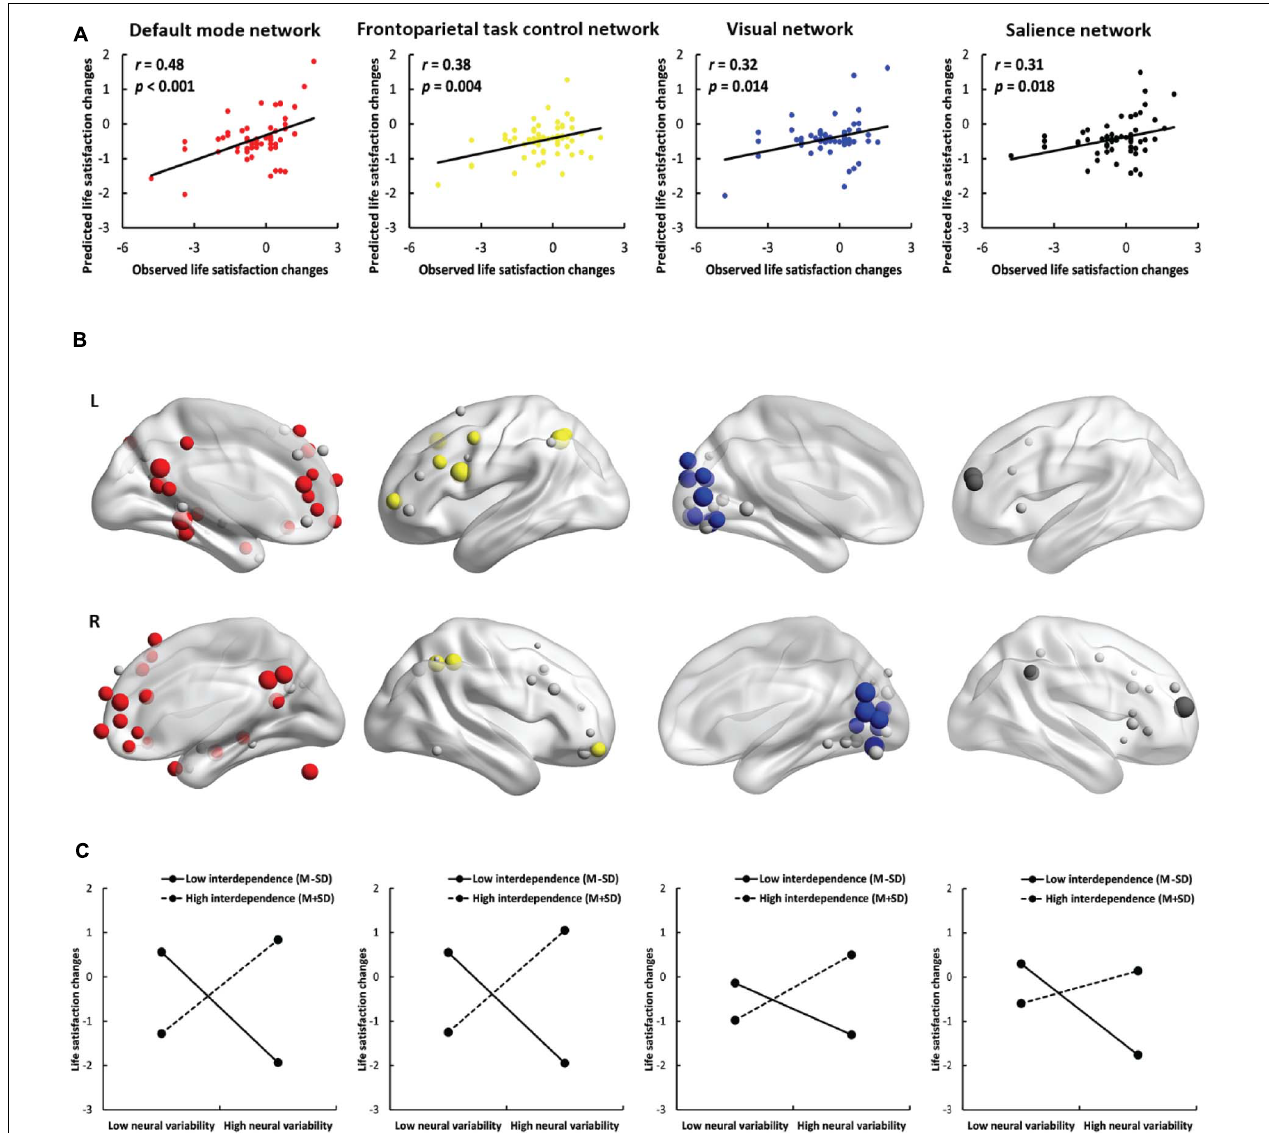
FIGURE 3 | Results of network-based prediction. (A) The predictive power of the positive model in the default mode network (red), frontoparietal task control network (yellow), visual network (blue) and salience network (black). (B) The location of important nodes in the default mode network (red), frontoparietal task control network (yellow), visual network (blue), salience network (black) and the remaining nodes (gray) in the four networks. (C) The simple effects of the network-based prediction in the four